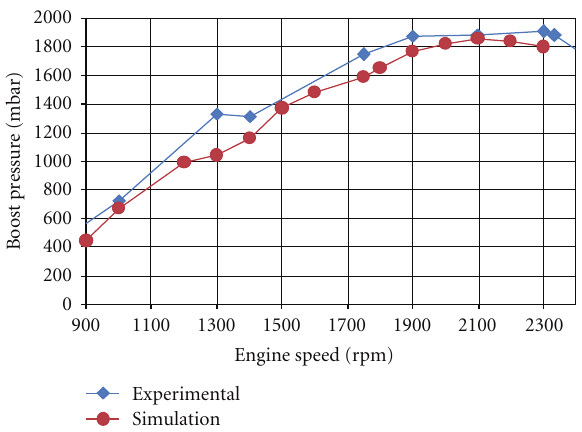
Figure 9: Comparison of experimental and simulated values of air flow.